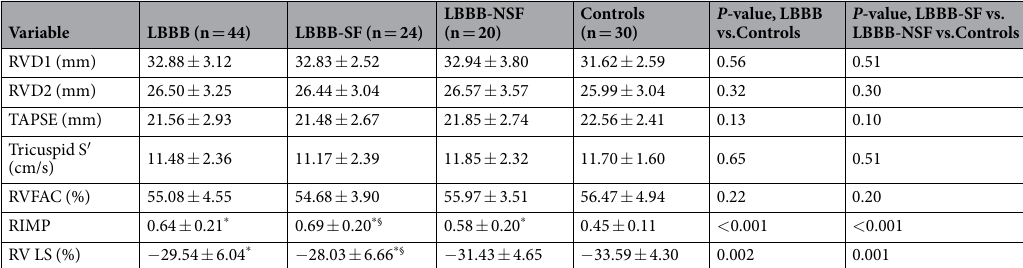
Table 2. Effect of SF on RV contractile performance in LBBB patients with preserved LVEF. Values shown are Mean ± SD. RV, right ventricle; RVD1, RV basal cavity diameter;RVD2, RV mid cavity diameter; TAPSE, tricuspid annular plane systolic excursion; RVFAC, RV fractional area change; RIMP, RV index of myocardial performance; LS, peak systolic longitudinal strain. * P < 0.05 versus control group; § P < 0.05 versus LBBB-NSF group.